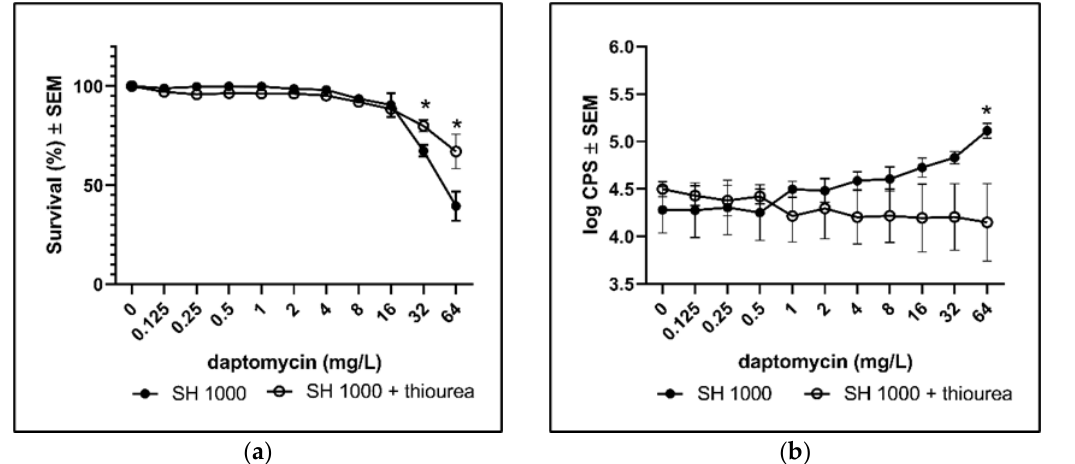
Figure 3. The rescuing effect of scavenging ROS with thiourea. Biofilms of the wild type (SH1000) were grown for 3 days before assessing the effect of the addition of thiourea during overnight treatment with daptomycin. ( a ) Bacterial survival was estimated by plating and counting of CFUs. ( b ) ROS formation according to DCHF fluorescence. Mean ± SEM of triplicate experimental set-ups are shown. Statistical significance was determined using two-way ANOVA, followed by Bonferroni’s multiple comparison tests. * p < 0.05.